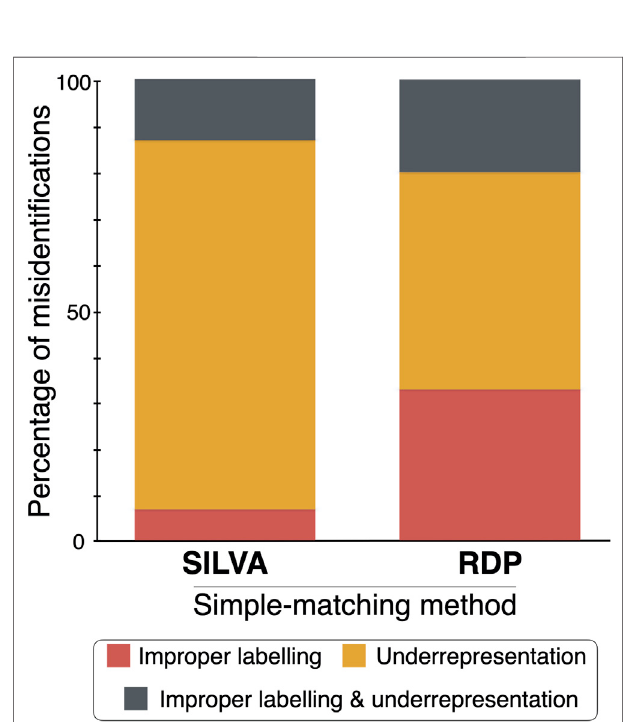
FIGURE 2 | Percentage of the fungal sequence misidenti fi cations in the SILVA and RDP simple-matching methods by either improper labelling, underrepresentation of groups of fungi, or